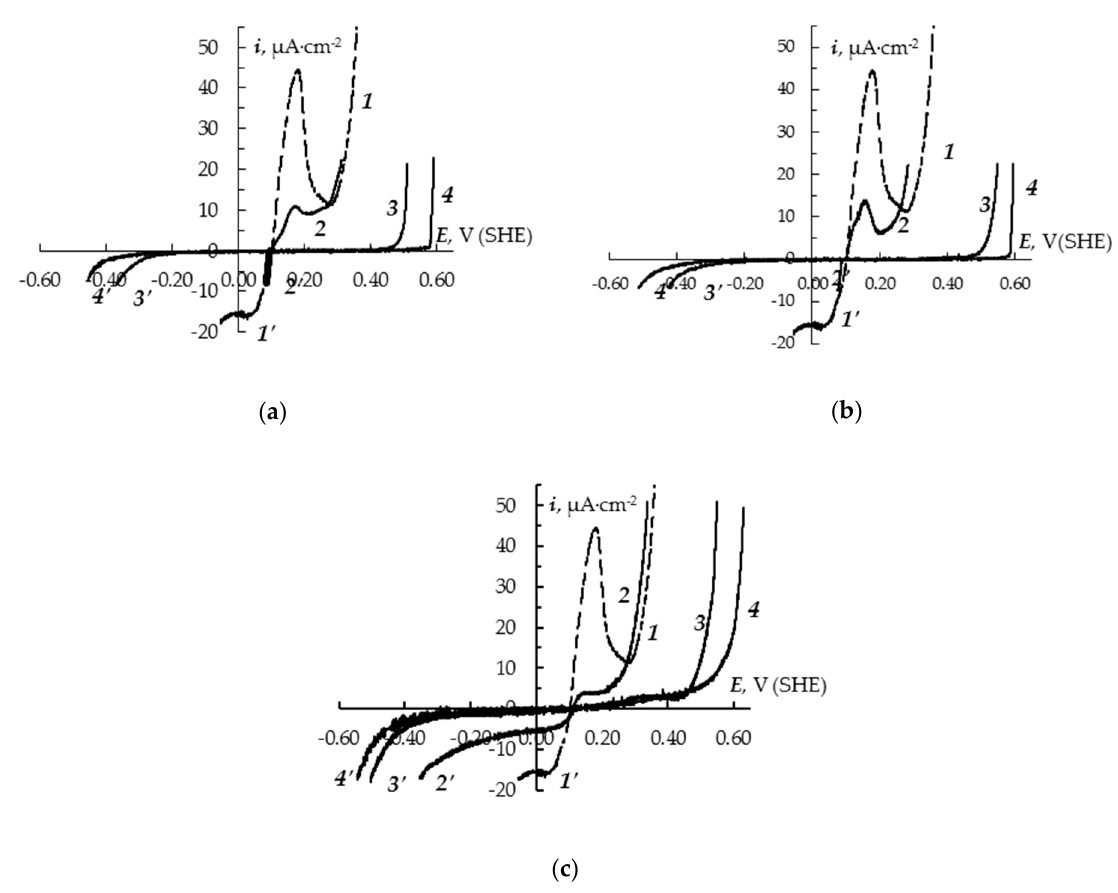
Figure 1. Anodic (1-4) and cathodic (1’-4’) polarization curves of α -brass in a borate buffer ( рН 7.4) with 0.01 M NaCl and 3-mercaptopropyl-5-amino-1 H -1,2,4-triazole ( a ), 3-mercaptobutyl-5-amino- 1 H -1,2,4-triazole ( b ) and 3-mercapto(3-methylbutyl)-5-amino-1 H -1,2,4-triazole ( c ) at the following concentrations: 1,1’–0; 2,2’–0.01 mM; 3,3’–0.10 mM; 4,4’–1.00 mM.